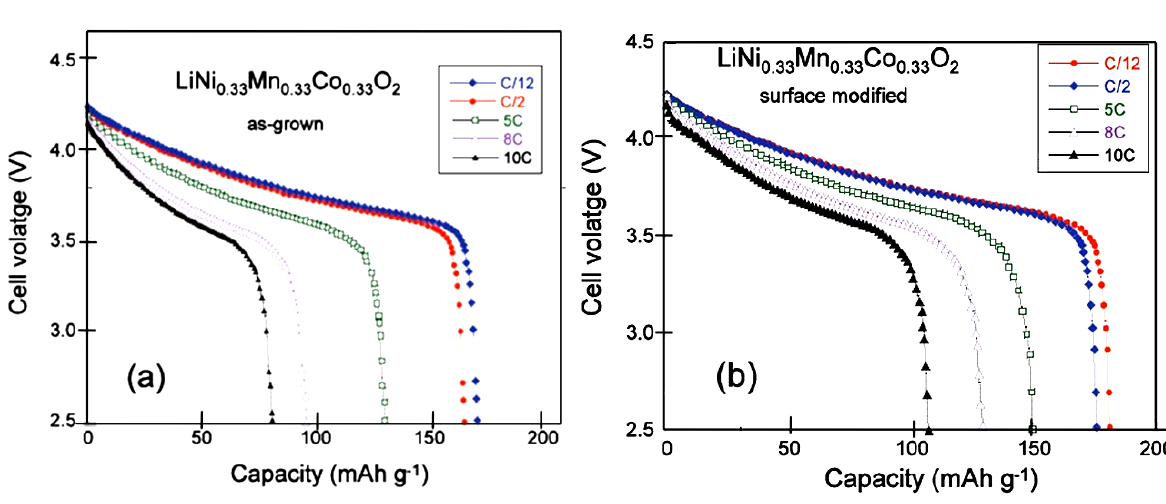
Figure 2. Discharge cell voltage vs. gravimetric capacity of the Li//LNMCO cells for various C-rate for ( a ) the as-grown cathode material and ( b ) heat treated sample with sucrose at 600 °C for 30 min in air. (Reprinted with permission from [57]. Copyright 2011 Elsevier.)